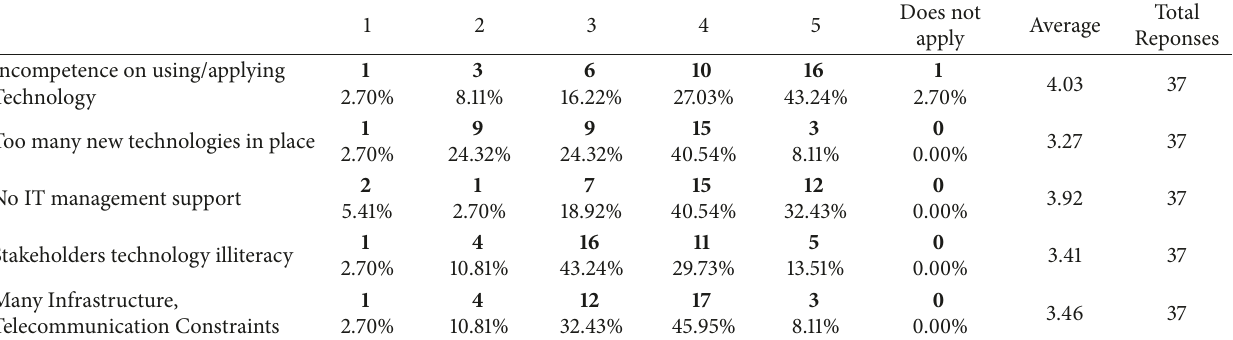
Table 5: Factors within Technology , relative complexity ranking.